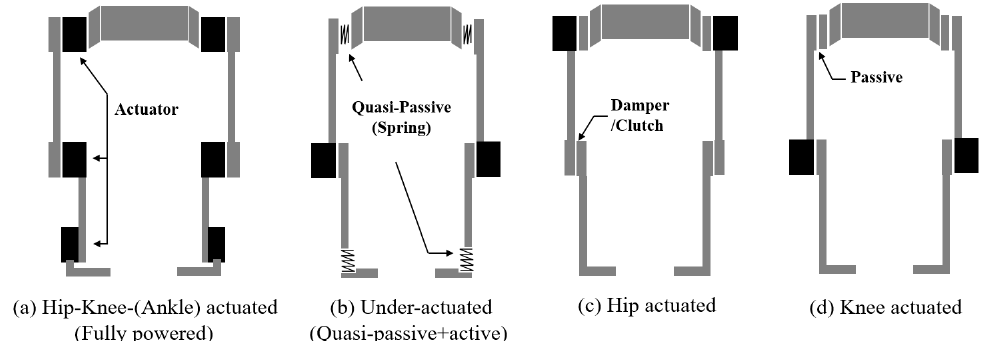
Figure 1. A brief classification of powered exoskeleton gait orthosis systems: ( a ) Fully powered exoskeleton with hip knee or hip knee ankle actuation; ( b ) Quasi passive exoskeleton with actuated or damped knee joint where the hip and ankle joint are connected with spring components; ( c ) Hip actuated exoskeletal gait orthosis with a clutch or damped knee joint; and ( d ) Knee actuated exoskeletal gait orthosis with passive hip joint.